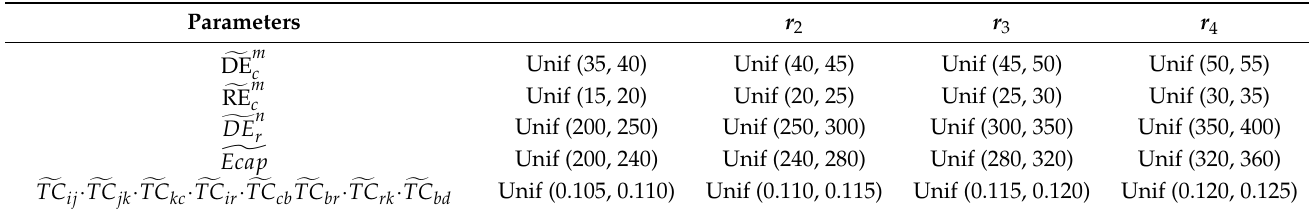
Table 2. The other parameters subject to Uniform distribution in the SCLSC network.